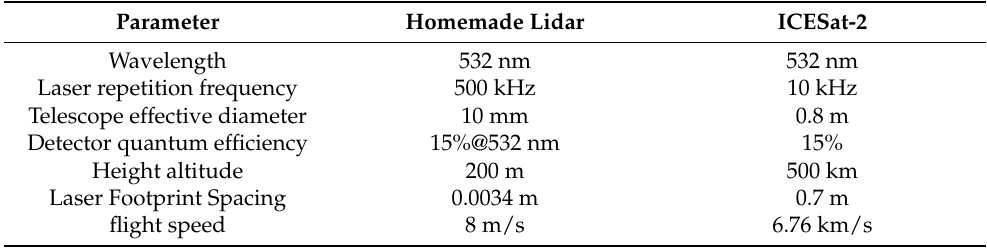
Table 2. Main specifications of the